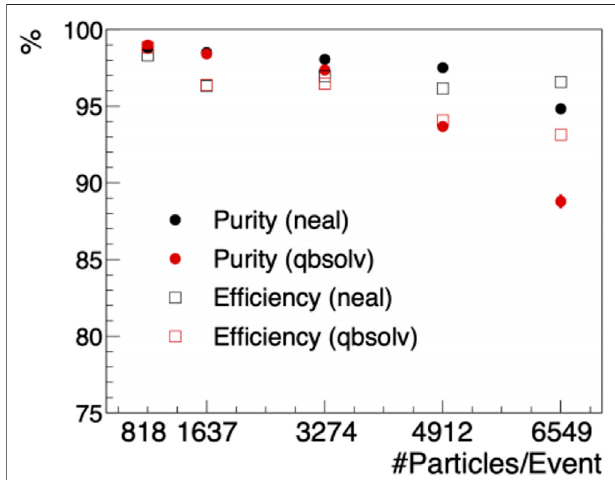
FIGURE 2 | The dependence of the ef fi ciency (open squares) and purity (closed circles) of the quantum annealing pattern recognition algorithm on the number of charged particles per event. Results from the qbsolv solver (red) and the neal solver (black) are compared. From